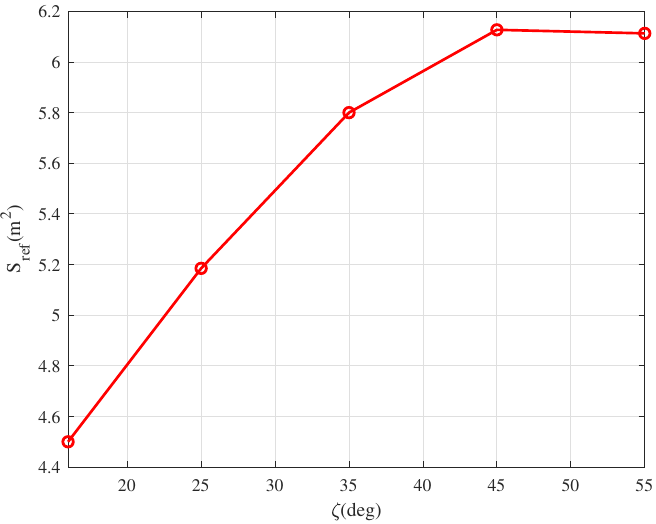
Figure 3. The variation in the S ref with respect to ζ .